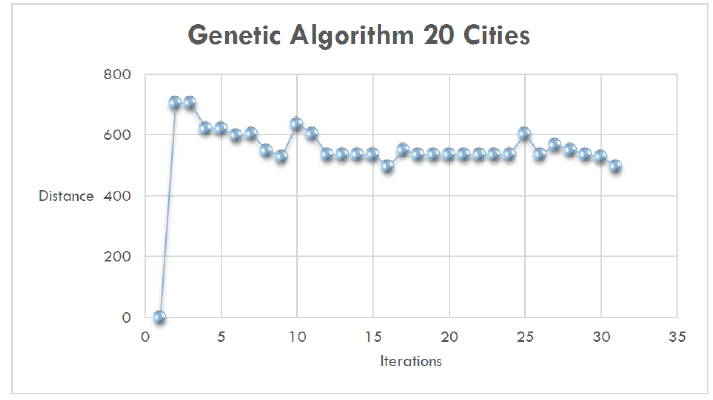
Fig. 10. GA Iteration